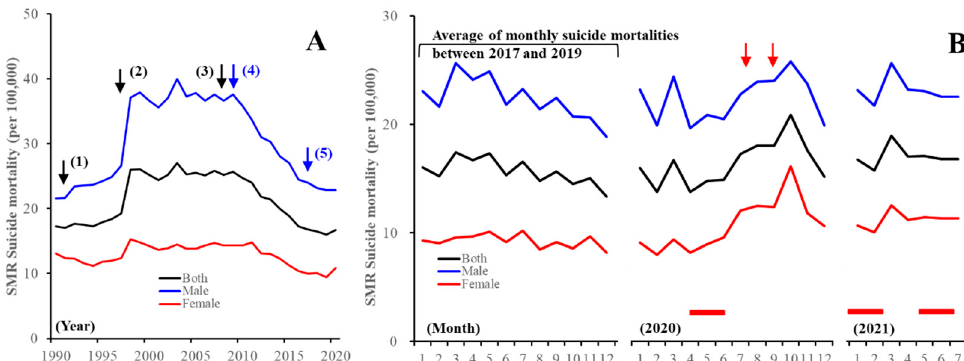
Figure 1. ( A ) Annual and ( B ) monthly suicide mortality in Japan. Ordinates indicate standardised mortality ratio (SMR) of suicide mortality of males and females (black lines), males (blue line), and females (red line) in Japan per 100,000 people. ( A ) Black arrows (1–3) indicate the collapse of the asset bubble, the Asian economic crisis, and the 2008 global financial crisis, respectively. Blue arrows (4) and (5) indicate the contribution of the Emergency Fund to Enhance Community-Based Suicide Countermeasures and the introduction of the Revised Basic Act on Suicide Prevention, respectively. ( B ) (left) Average SMR suicide mortalities during 2017–2019. (middle, right) Monthly SMR suicide mortality in 2020 and 2021, respectively. Red columns, period of 2019 novel coronavirus disease (COVID-19) stay-home orders; red arrows, mass media reports regarding celebrity